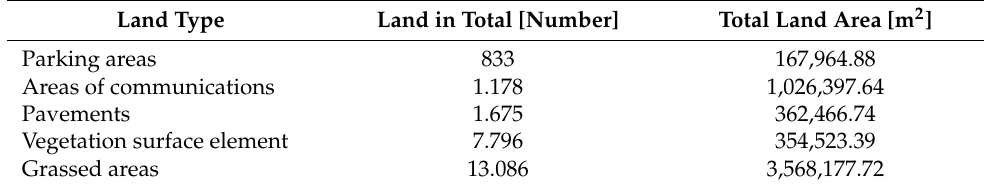
Table 2. Analysis of dimensions and location of individual areas and surfaces (source: authors). Land